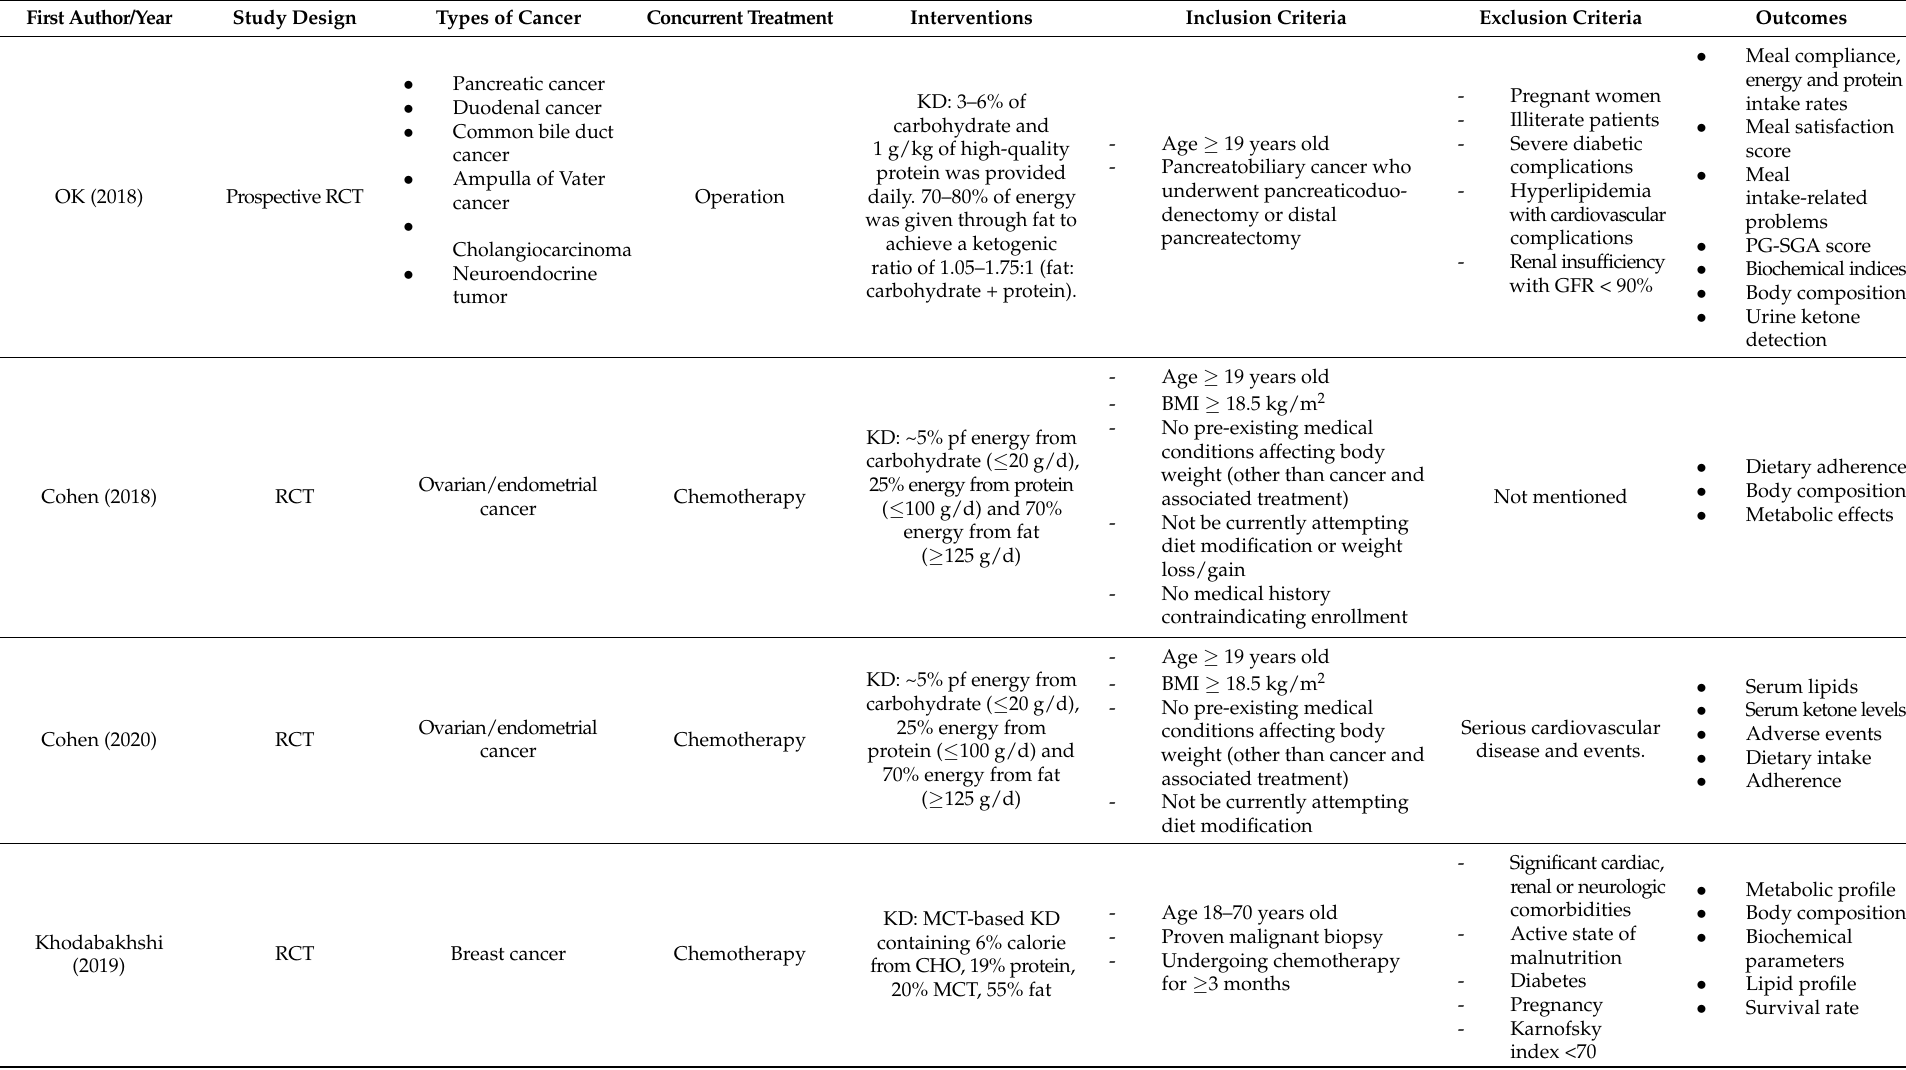
Table 3. General characteristics of included studies in